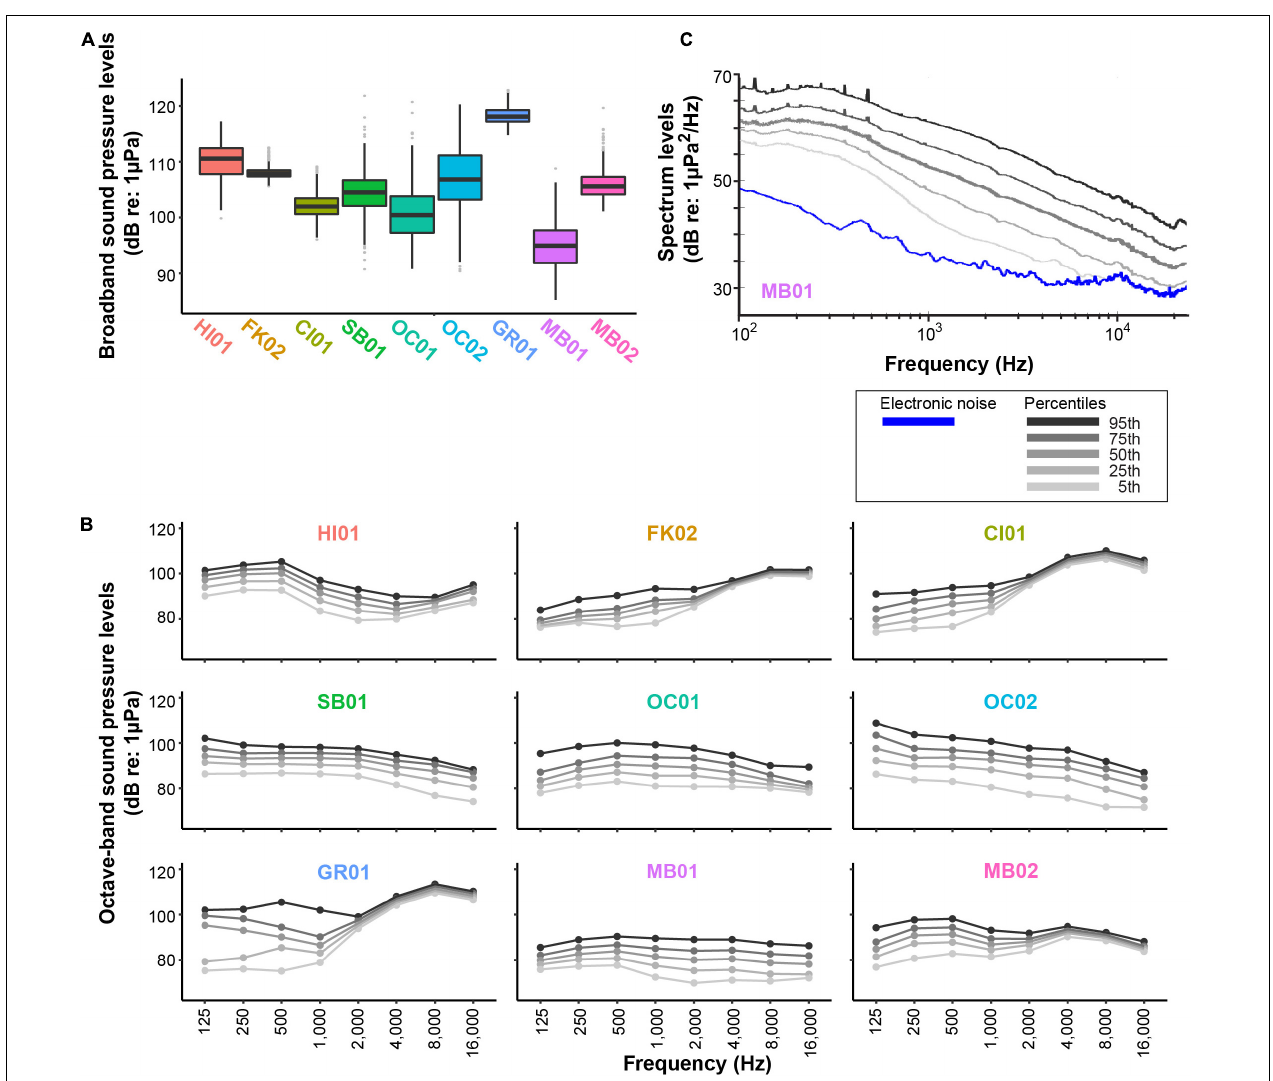
FIGURE 3 | Comparison of sound levels across sites. Hourly band sound pressure levels for the 31-day periods at nine sites are shown as (A) broadband sound level (BB) comparison as box plots with line at median value, box includes 25th-75th percentiles, (B) octave band (OL) percentile sound levels at each site (5, 25, 50, 75, 95th), and (C) narrow band (1 Hz) percentile spectrum levels at MB01 (5, 25, 50, 75, 95th). The blue line shows the noise floor of the instrument, measured in air under quiet conditions with the hydrophone connected and adjusted for the system transfer function. The accuracy of this method is frequency dependent and may result in mechanical noise transmitted through the room and floor at frequencies below 1 kHz. While the line was generated from a single instrument, we are using it to represent all instruments used in this study. Spectrum levels were truncated at 88 Hz for broadband and octave band sound level computation and hence excluded from the comparison due to uncertainty in propagation conditions and instrument